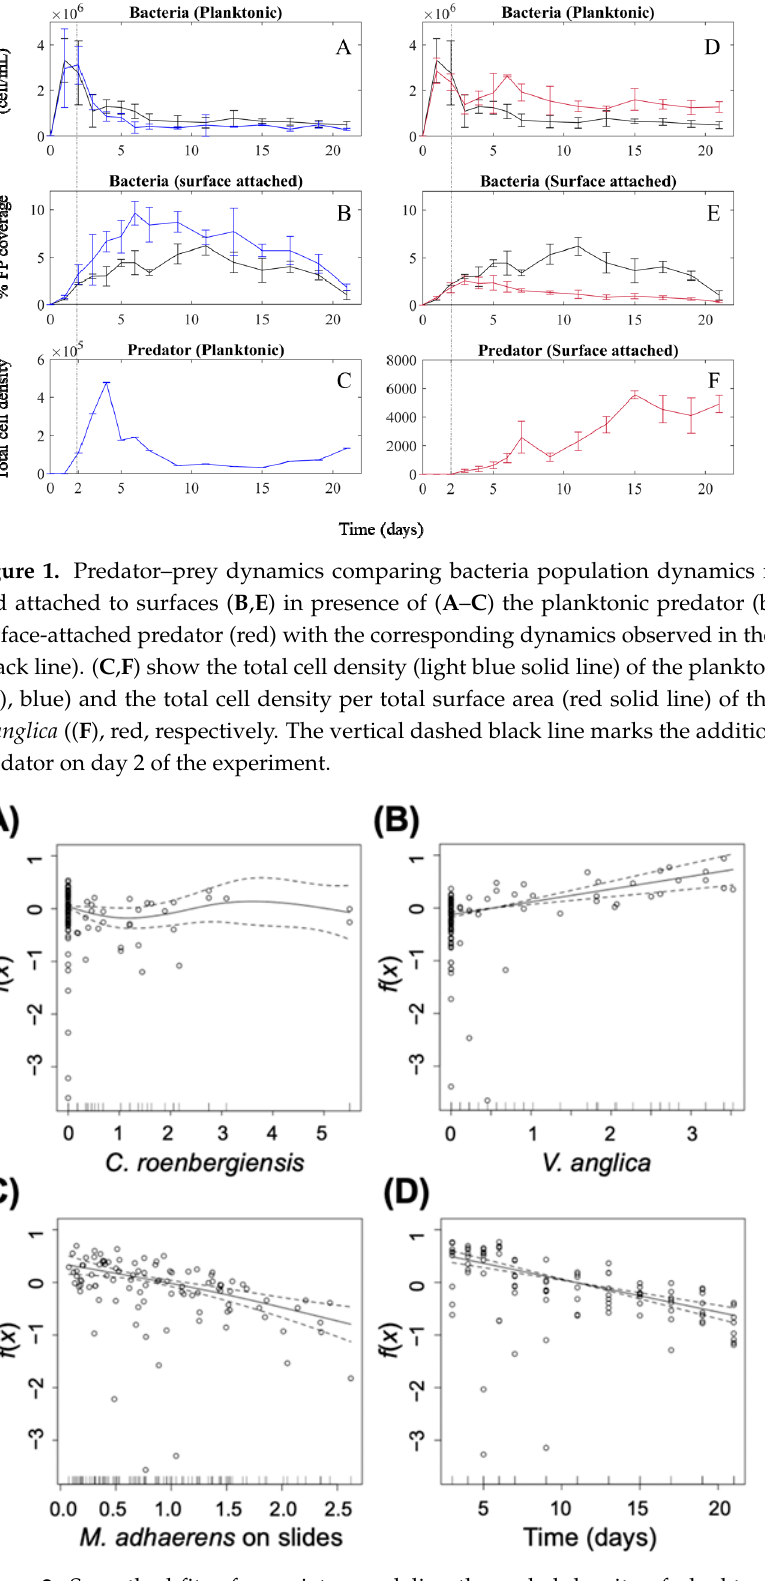
Figure 2. Smoothed fits of covariates modeling the scaled density of planktonic M. adhaerens for the scaled densities of ( A ) C. roenbergensis , ( B ) V. anglica , ( C ) surface-associated M. adhaerens , and ( D ) time. The y -axis represents the spline function. Circles are the data from the experiment. Solid lines represent fitting curves. Dashed lines indicate the 95% confidence intervals.